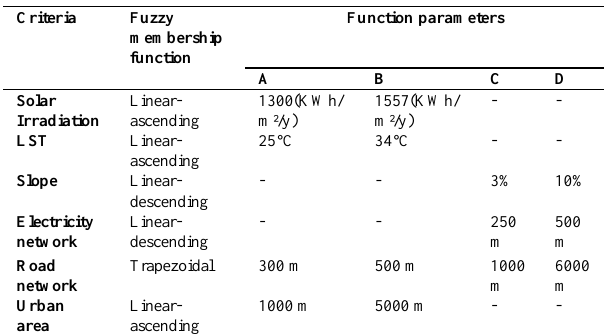
Table 4. Criteria used in the fuzzy model of this